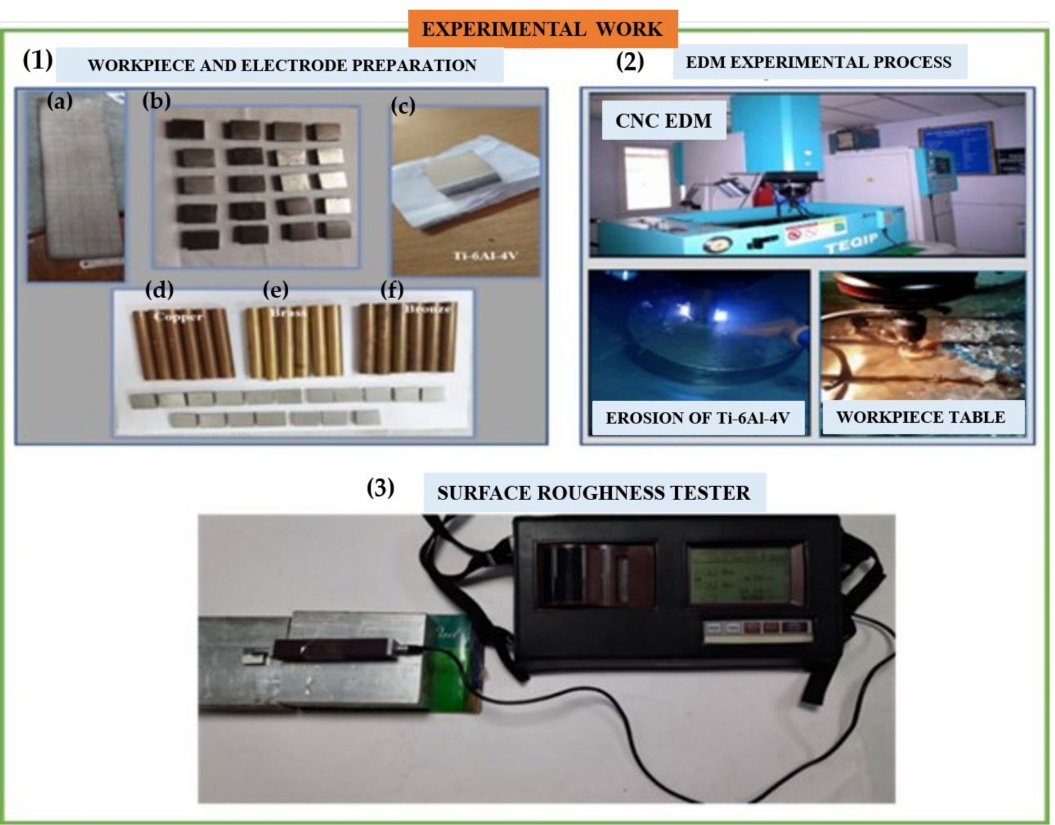
Figure 1. EDC Experimental Setup. ( 1 ) ( a ) Ti6Al4V Plate, ( b ) Substrate Preparation, ( c ) Polished Substrate, ( d ) Copper, ( e ) Brass and ( f ) Bronze; ( 2 ) EDM Experimental Process; ( 3 ) Surface Roughness